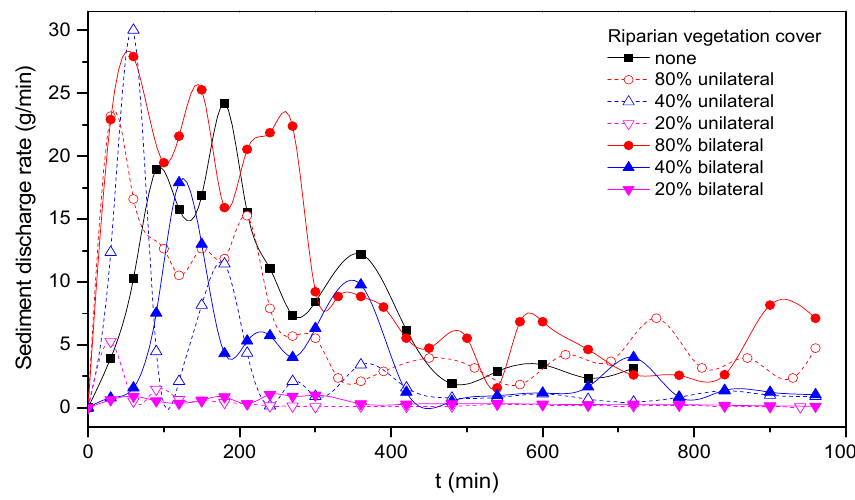
Figure 17. Time history of the sediment transport rate in bends. Table 5. Statistics of final stable sediment transport rate in different working conditions. Run